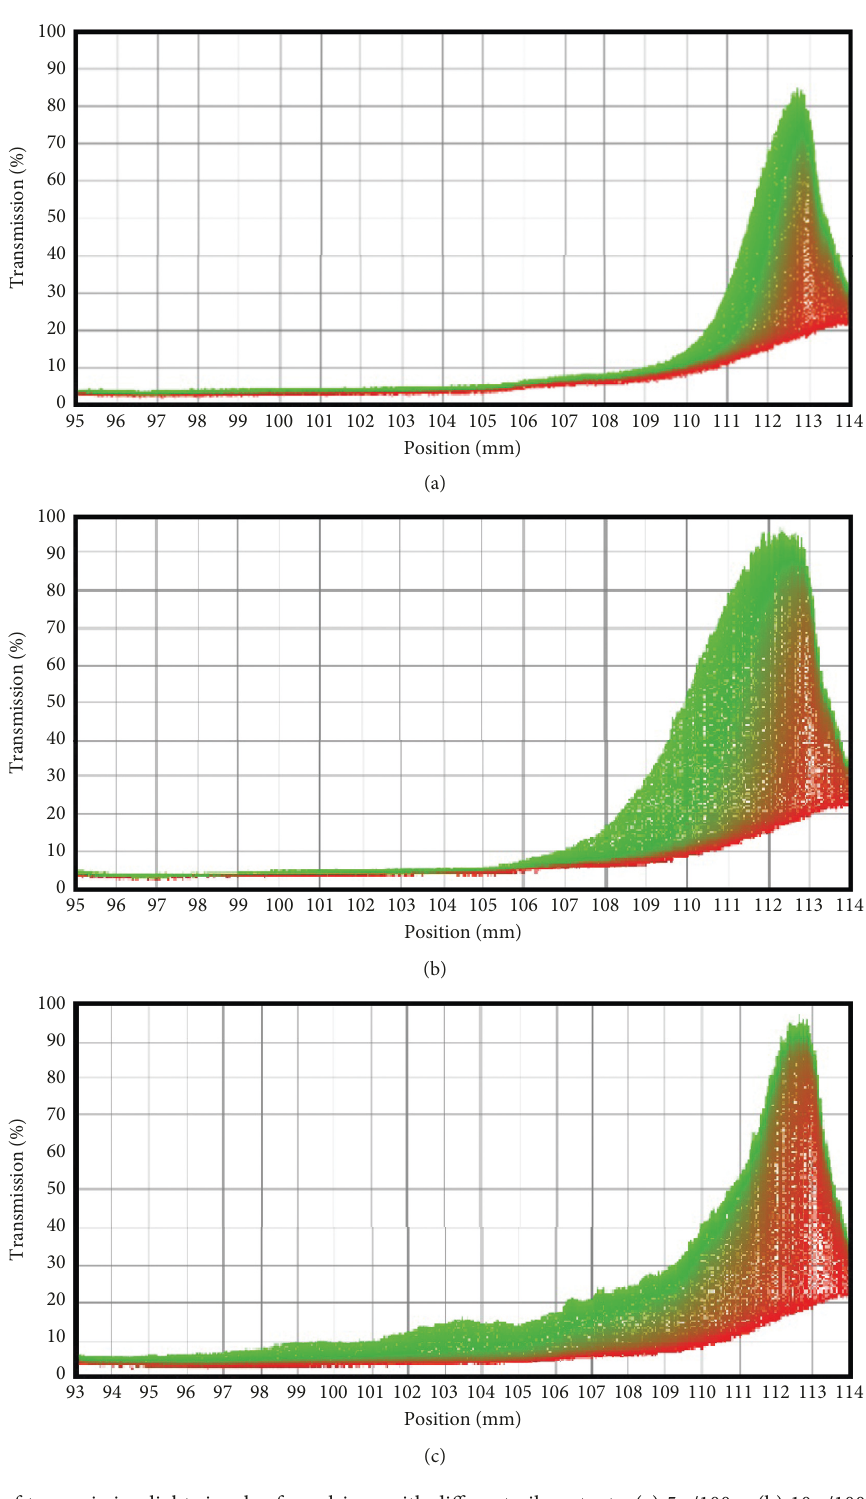
Figure 1: Evolution of transmission light signals of emulsions with different oil contents: (a) 5g/100g; (b) 10 g/100g; (c) 20g/100g. The bottom red line represents the first scanning profile, and the top green line represents the last scanning